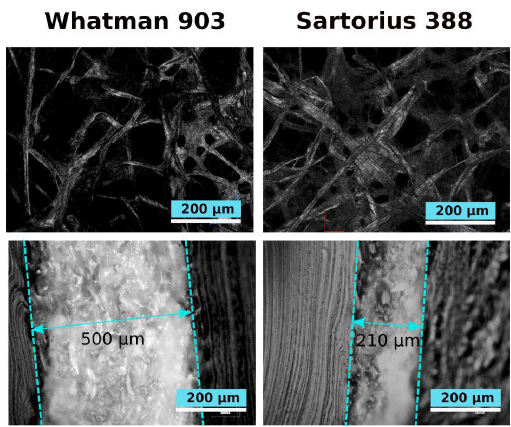
Figure 5. Images of the top surfaces (first row) and cross-sections (second row) of the filter papers, Whatman 903 and Sartorius 388, used in the spreading experiments